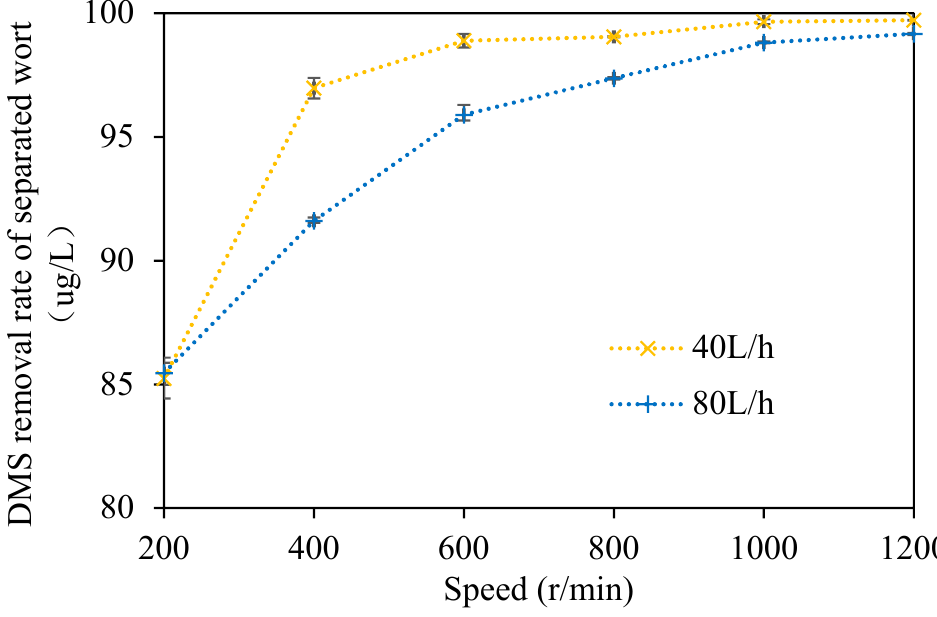
Figure 5. Removal rate of DMS in separated wort.